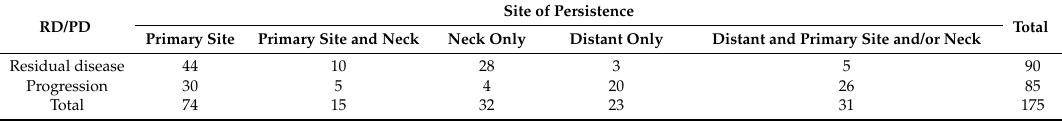
Table 2. Site and extent of persistent HNC after first-line therapy. Residual disease included partial response and no change according to WHO response criteria. Progressive disease frequently occurred at distant